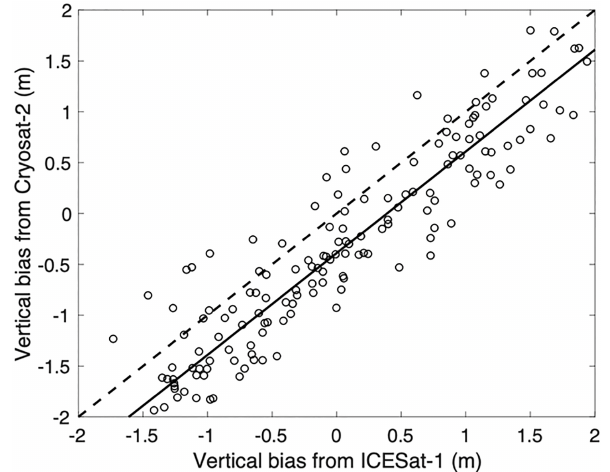
Figure 2. Plot of vertical bias (i.e., the mean of residuals) between REMA strip DEMs and overlapping point clouds from ICESat-1 laser altimetry and CryoSat-2 radar altimetry. Only strips with stan- dard deviations in residuals less than 0.25m are plotted. The solid line is unity, shifted by the mean difference among biases